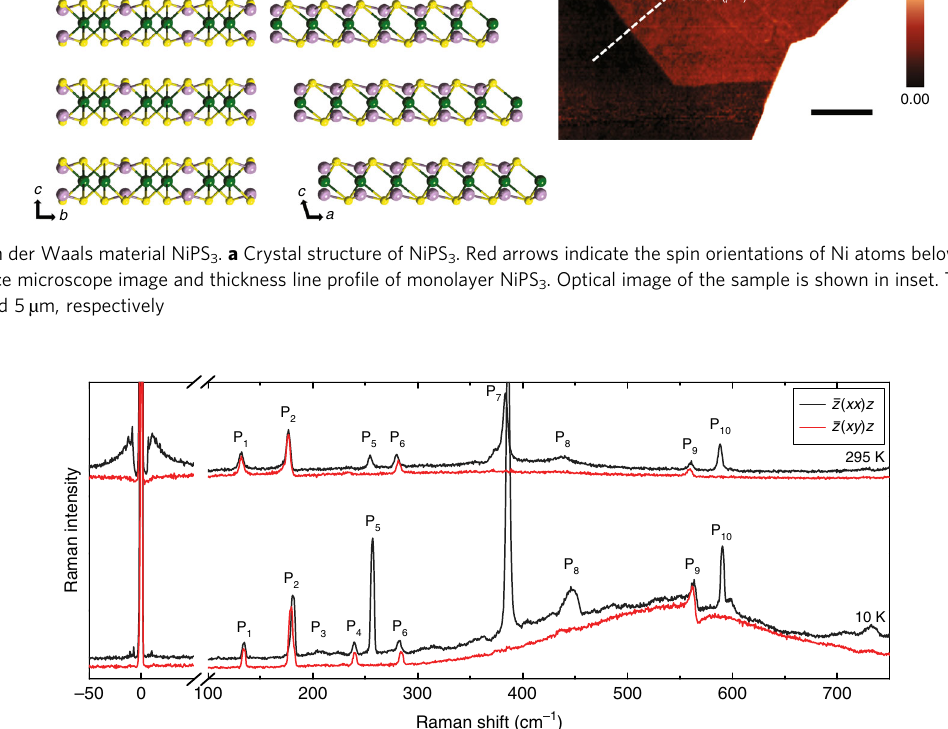
Fig. 2 Raman spectra of bulk NiPS 3 . Comparison of Raman spectra measured at T = 10 and 295 K in parallel (cid:1) z ð xx Þ z ½ (cid:3) (black) and cross (cid:1) z ð xy Þ z ½ (cid:3)